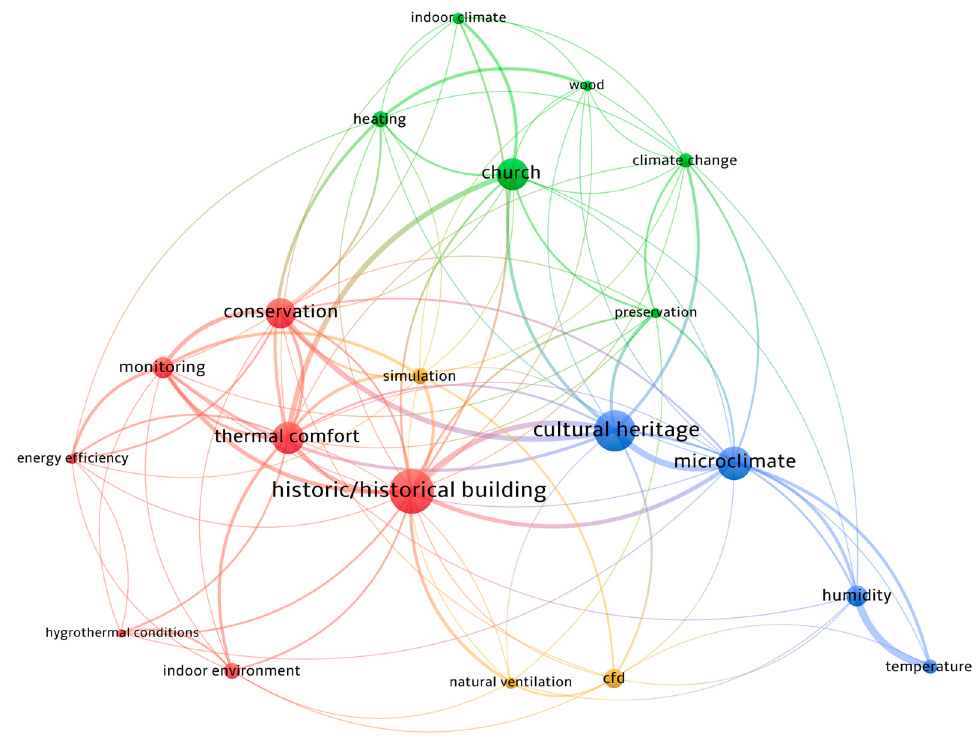
Figure 3. Analysis of the most commonly used keywords and their co-occurrence in the VOSviewer software tool.